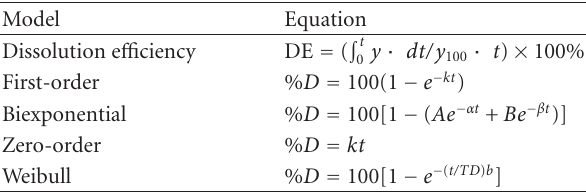
Table 2: Mathematical models related to dissolution experiments.